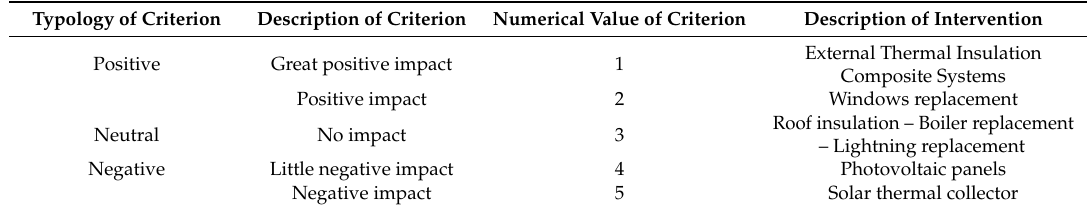
Table 12. Architectural impact